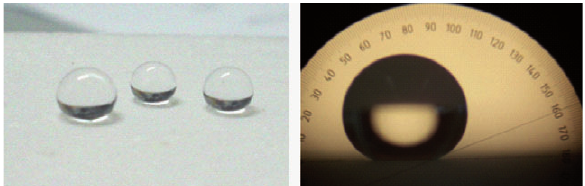
Figure 6 Water drops with almost spherical shapes on a super- hydrophobic surface. The static contact angle, measured on the right, is clearly higher than 150 °